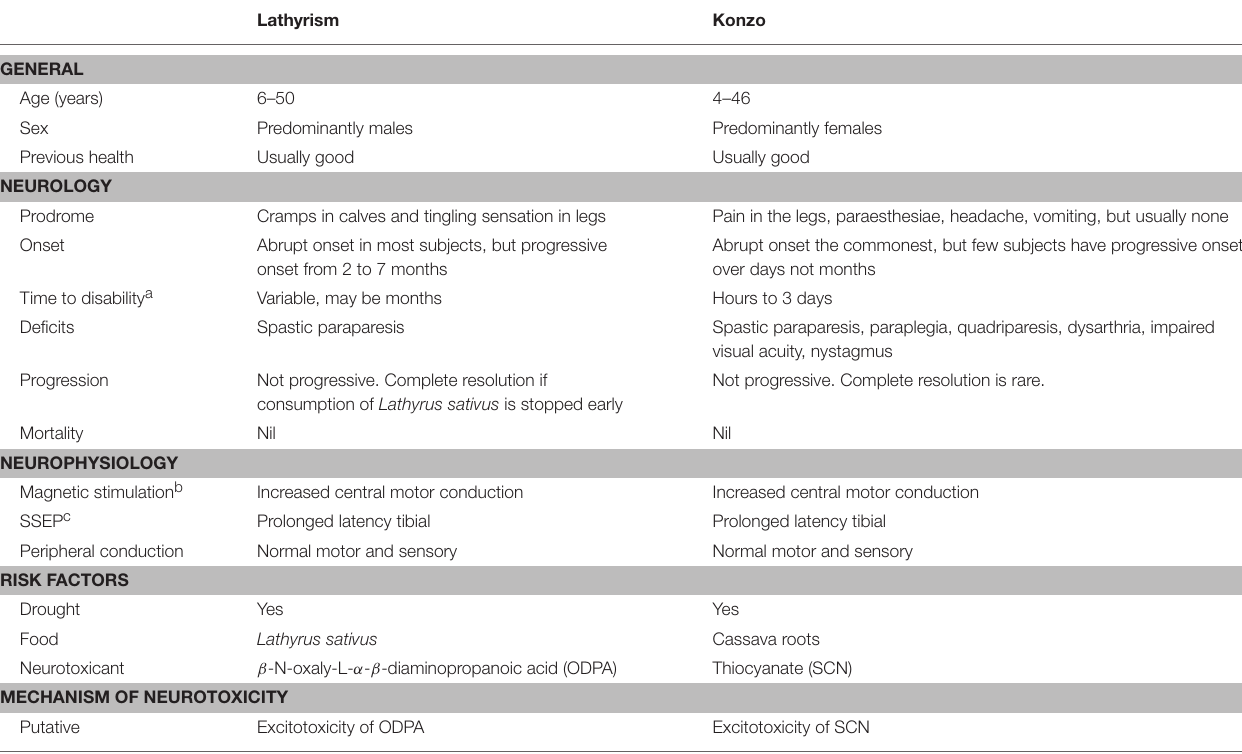
TABLE 1 | Comparison of lathyrism and